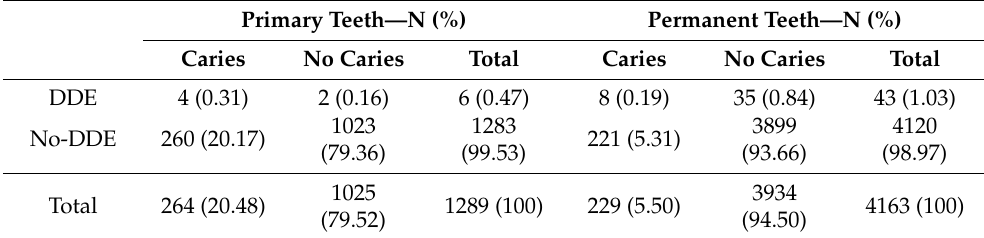
Table 7. Distribution of caries and DDE